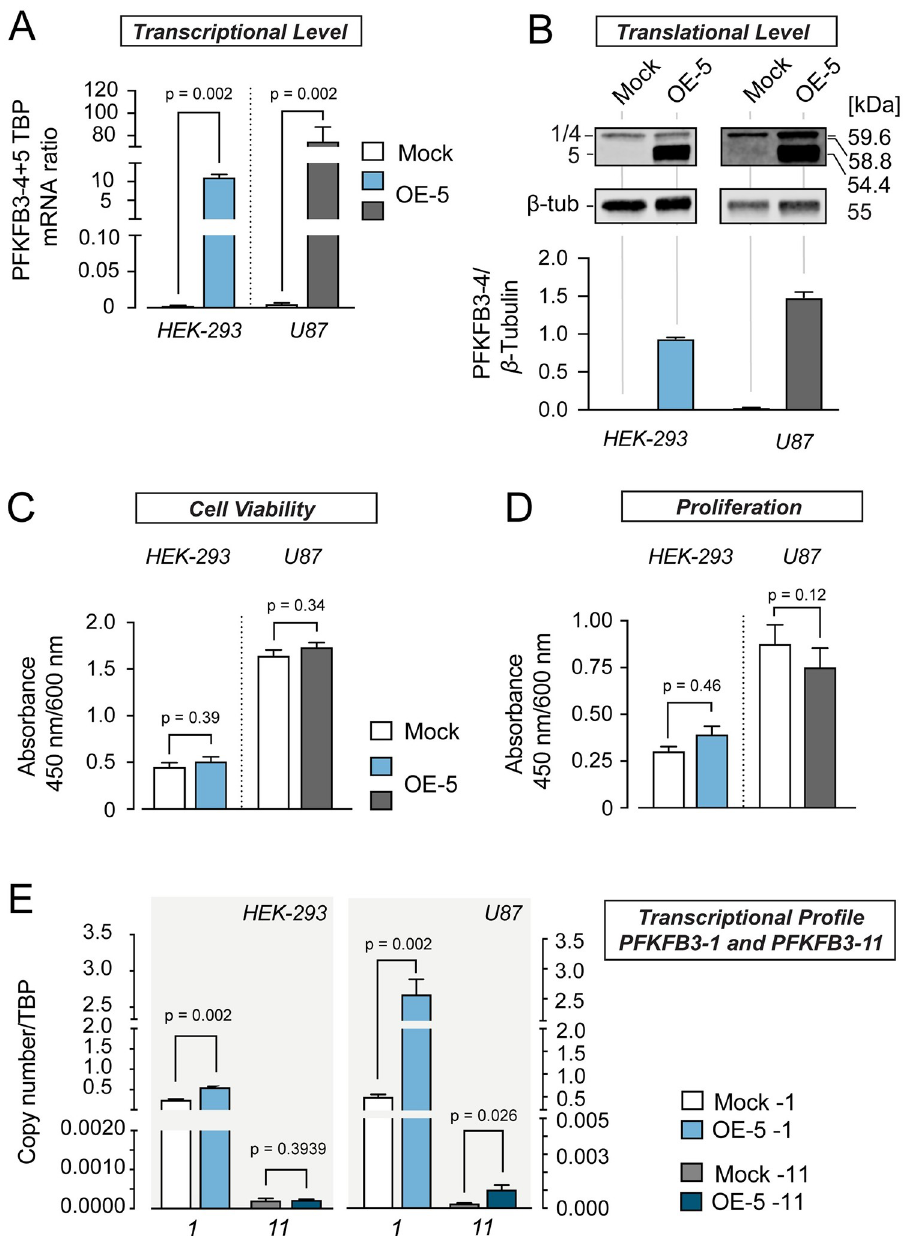
Fig 5. Transient overexpression of PFKFB3-5 has no impact on cell viability and proliferation but changes the transcriptional profile of PFKFB3-1 and -11. (A) Quantification of PFKFB3-5 mRNA levels from HEK-293 (blue) and U87 cells (grey) transiently overexpressing PFKFB3-5. Cells were harvested 24 h after transfection. PFKFB3-5 mRNA quantity was compared to mock samples and normalized to the amount of TBP mRNA measured by quantitative PCR (N = 3, n = 2). (B) Western blot analysis to confirm the overexpression of PFKFB3-5 with polyclonal PFKFB3 antibody. β -Tubulin served as loading control, 10 μ g protein were loaded per lane. Cells were harvested 48 h after transfection. The ratio of protein bands (PFKFB3-5 to β -Tubulin) was calculated from the intensity values of protein bands (n = 3). (C) Effect of PFKFB3-5 overexpression on cell viability, measured by WST-1 assay. Cells were harvested 24 hours after transfection. After a 4 h incubation period with WST-1 reagent the absorbance was measured at 450 nm/600 nm (N = 7, n = 7–8). (D) Effect of PFKFB3-5 overexpression on proliferation measured by BrdU-assay. Cells were harvested 24 h after transfection. After an 20 h incubation period with BrdU, the absorbance was measured at 450 nm/600 nm (N = 7, n = 7). (E) Impact of transient overexpression of PFKFB3-5 on the mRNA levels of PFKFB3- 1 and PFKFB3-11 . Cells were harvested 24 h after transfection. The quantity of PFKFB3 mRNA was measured as duplicate (n = 2) in three independent experiments (N = 3) by quantitative PCR and was normalized to the amount of TBP mRNA. Values represent the mean ± SEM. Groups were compared using the paired t-test or Mann Whitney test.